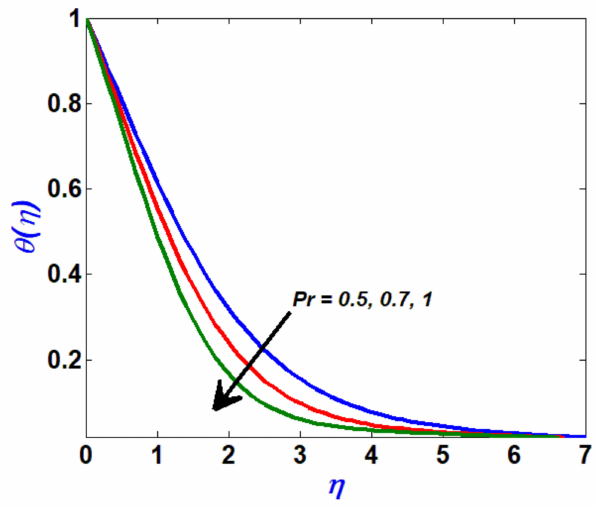
Figure 7. Temperature profile with variation in Pr .